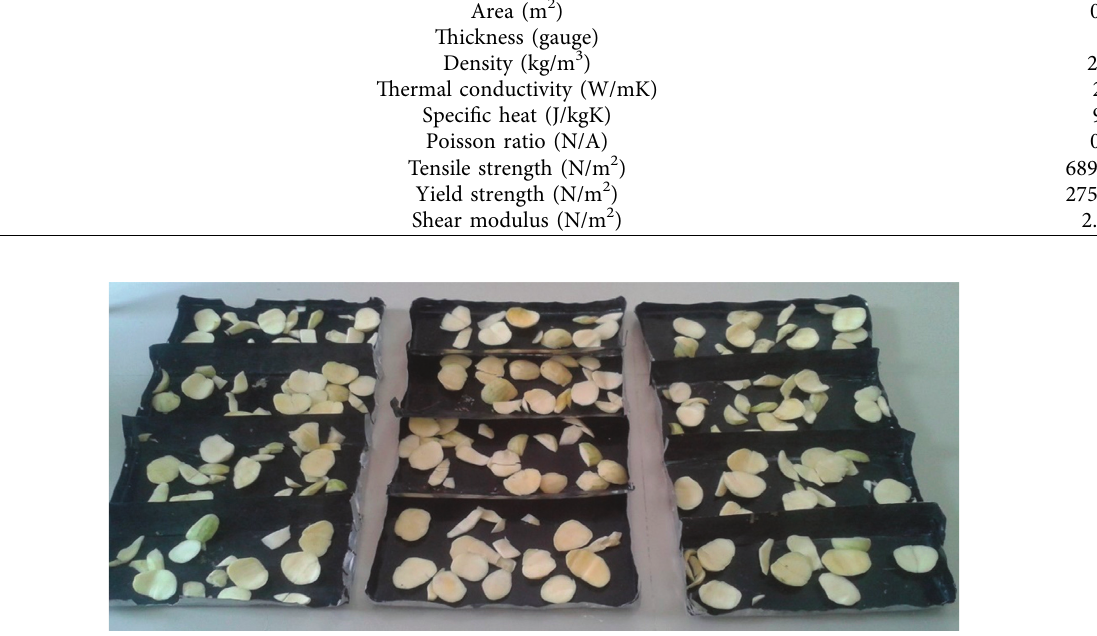
Figure 6: Potato chips in